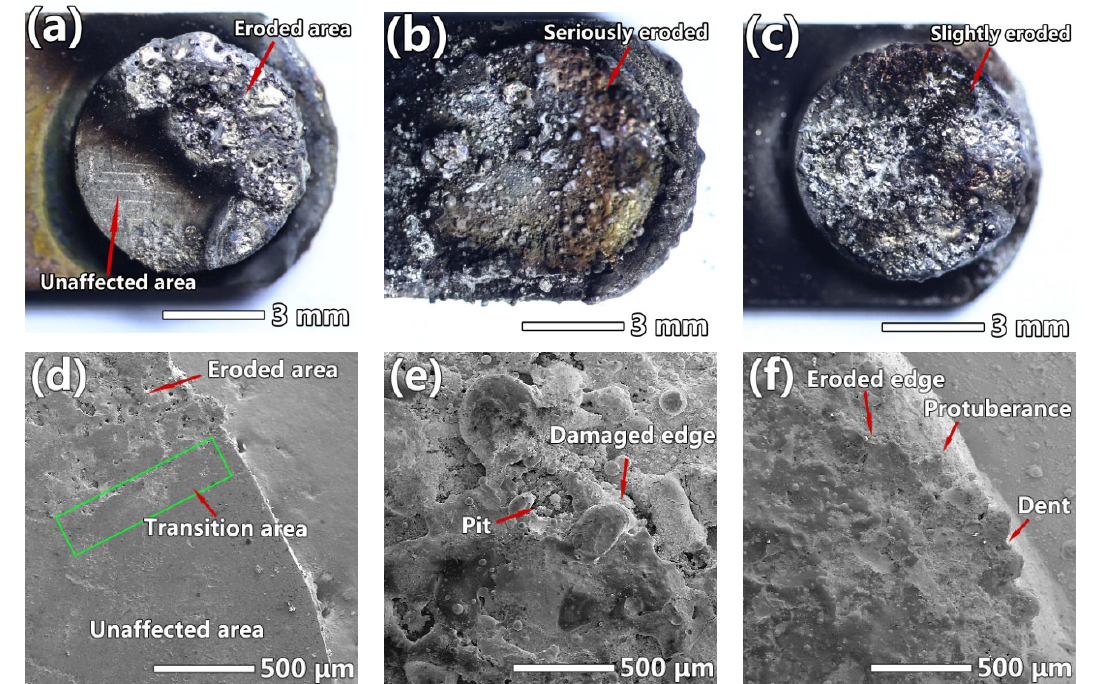
Fig. 3 (a–c) Optical and (d–f) low-magnification SEM images on the surfaces of Ag/10TSC, Ag/20TSC, and Ag/CdO